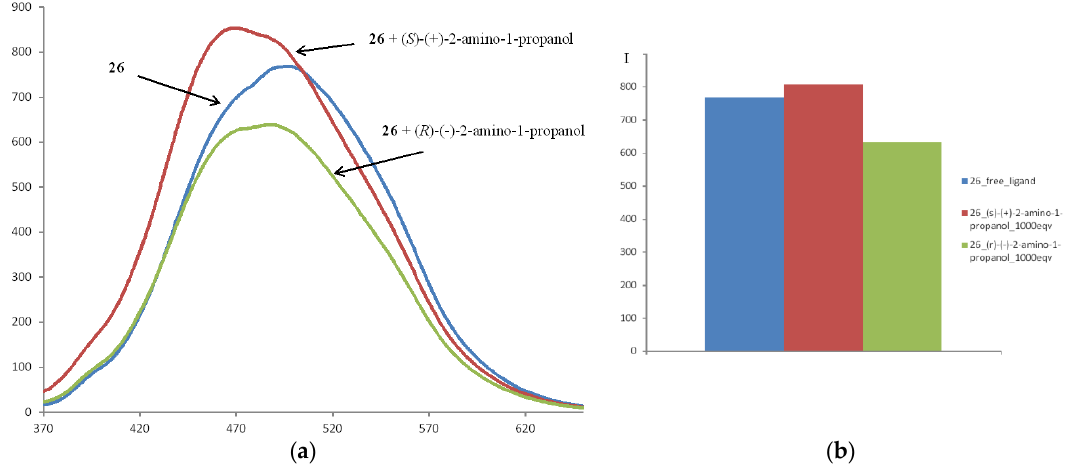
Figure 16. Fluorescence spectra of compound 26 in the presence of ( R )- and ( S )-enantiomers of 2-amino-1-propanol (1000 equiv.); ( a ) general view; ( b ) schematic representation of the changes in emission.